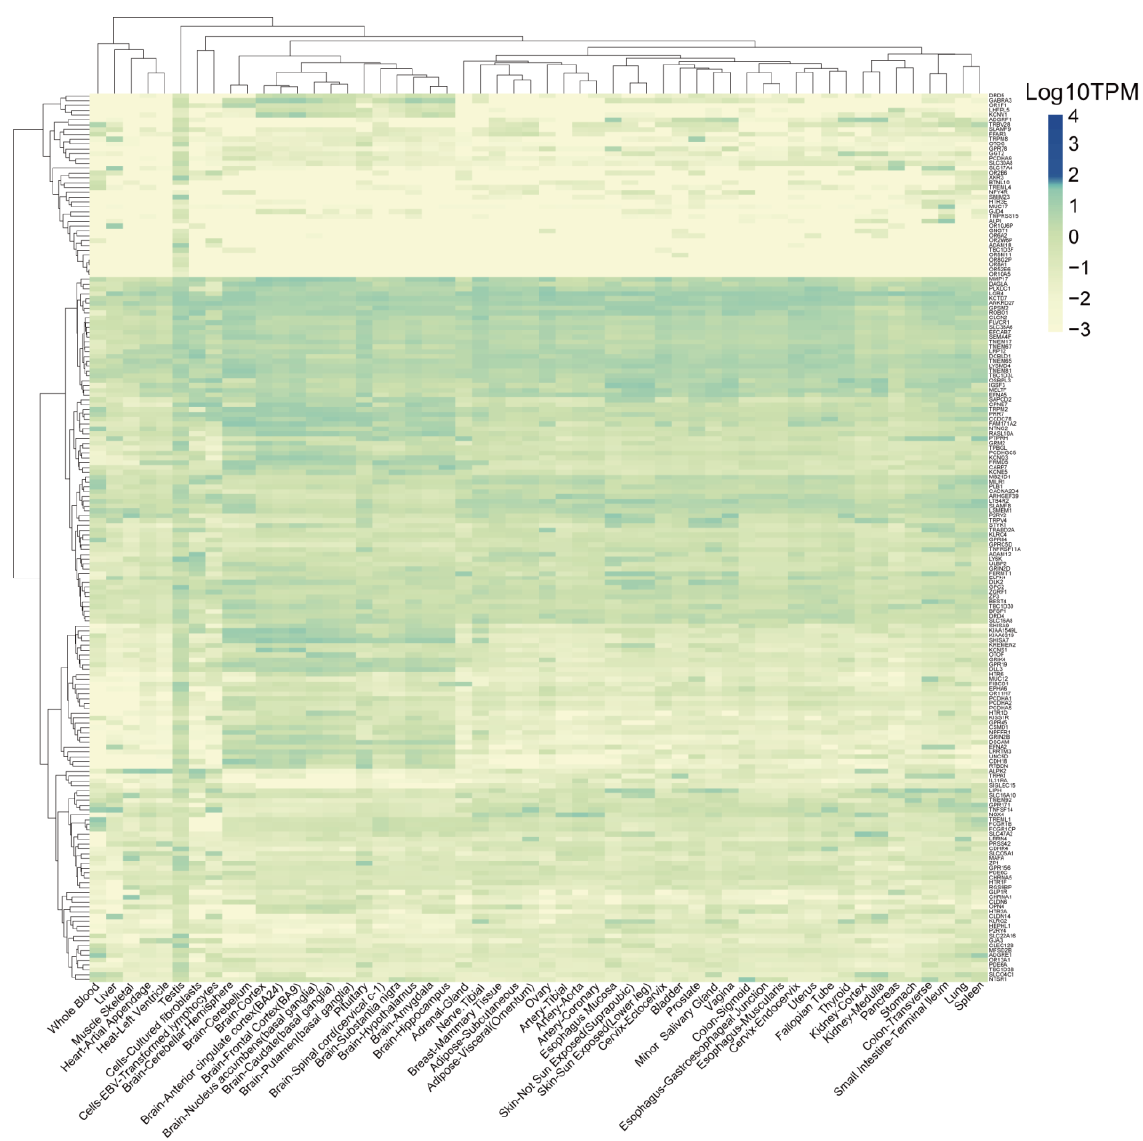
Figure 6. Heatmap displays the expression levels of the low-expression genes in the 54 normal tissues from the GTEx database.